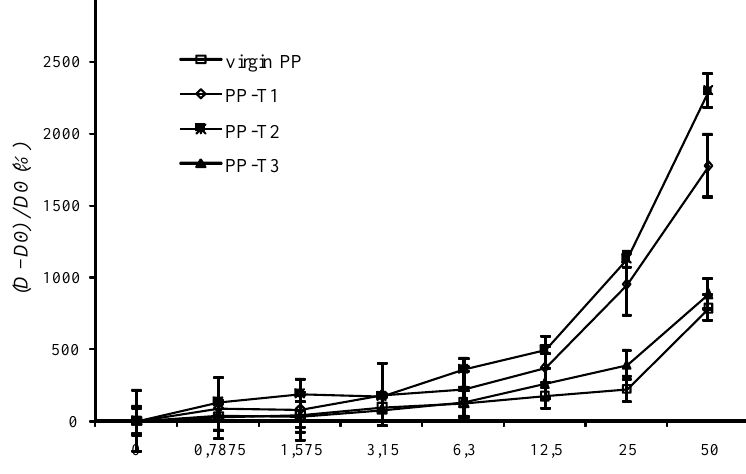
Figure 2. Dependence of the (D – D0)/D0 ratio on the well inner-surface nature and the antigen concentration. ((capture antibody) = 10 µg∙mL –1 , (detection antibody) = 1 µg∙mL –1